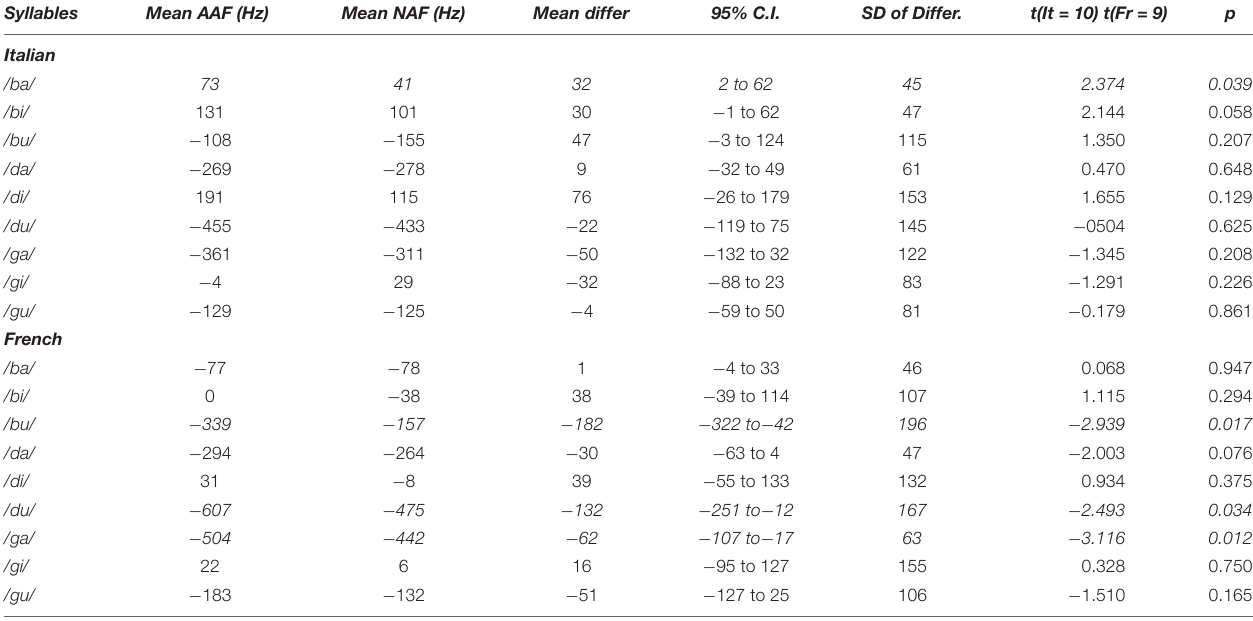
TABLE 6 | For each syllable and each language under NAF and AAF condition: Mean values (Hz) of (cid:49) F2, mean of the difference (Hz), 95% of the Confidence Interval (Hz), Standard Deviation of the Differences (Hz), t value (Degrees of Freedom), and p value (matched pairs t -tests).